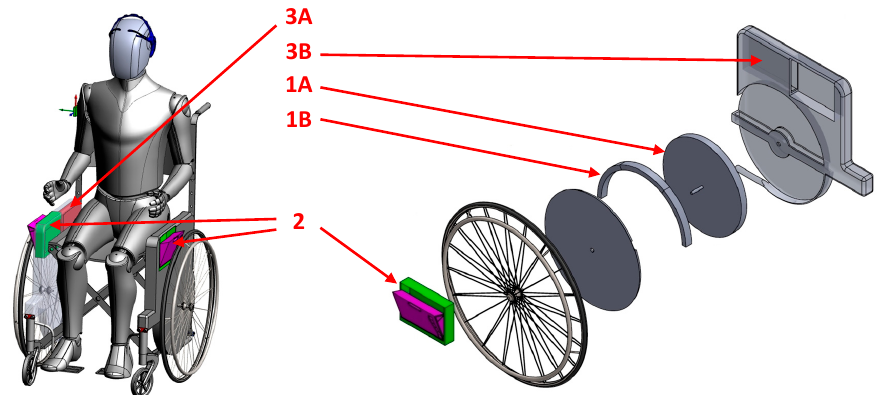
Figure 2. Configurable wheelchair and parts of its electrical subsystem: 1—Electrical motor-generator and its electronic driver (1A—rotor, 1B—stator parts), 2—batteries and the corresponding Battery Management Systems (BMS), 3—charger (3A—charger, 3B—its compartment.